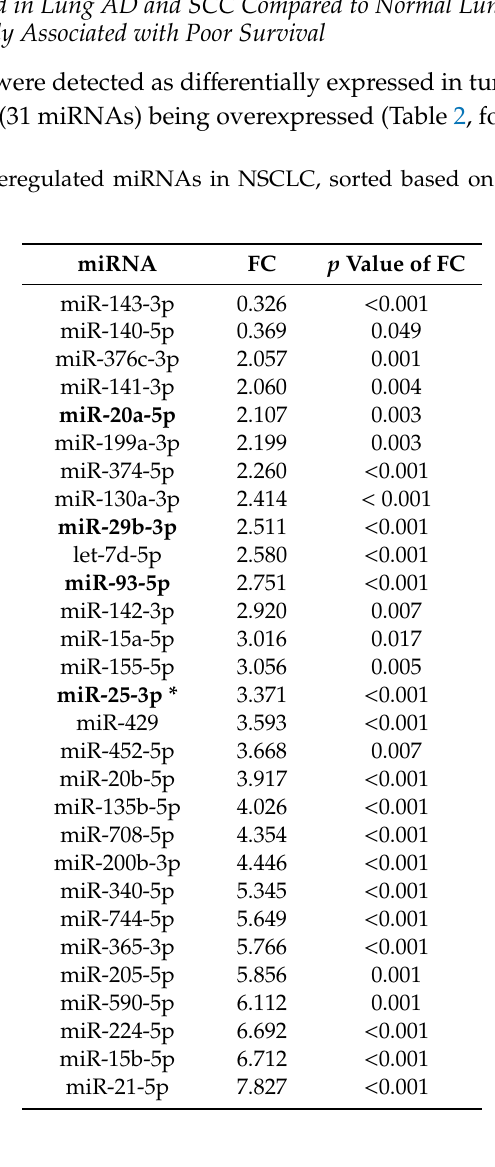
Figure 1. EGFR and KRAS mutation analysis. Two tumors were positive for KRAS p.Gly12Val, two were positive for KRAS p.Gly12Cys, one tumor was positive for KRAS p.Gly12Asp and one was positive for NRAS p.Gln61Arg and for KRAS p.Gln61His. 2.3. miRNAs Are Deregulated in Lung AD and SCC Compared to Normal Lung Tissues, and miR-25-3p